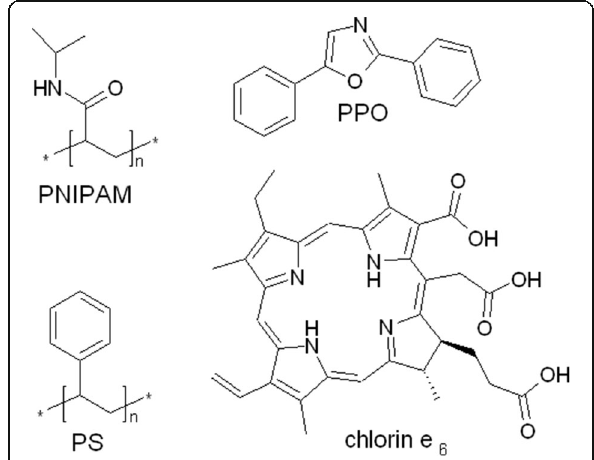
Fig. 1 Structures of the components of the PS-PPO-PNIPAM hybrid nanosystem and chlorin e